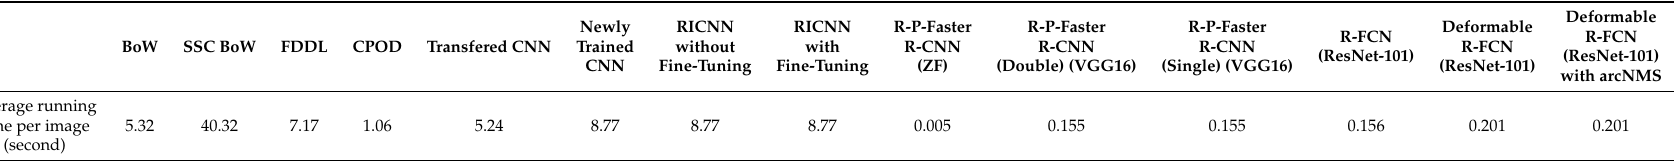
Table 2. Computation time comparisons for objects’ detection